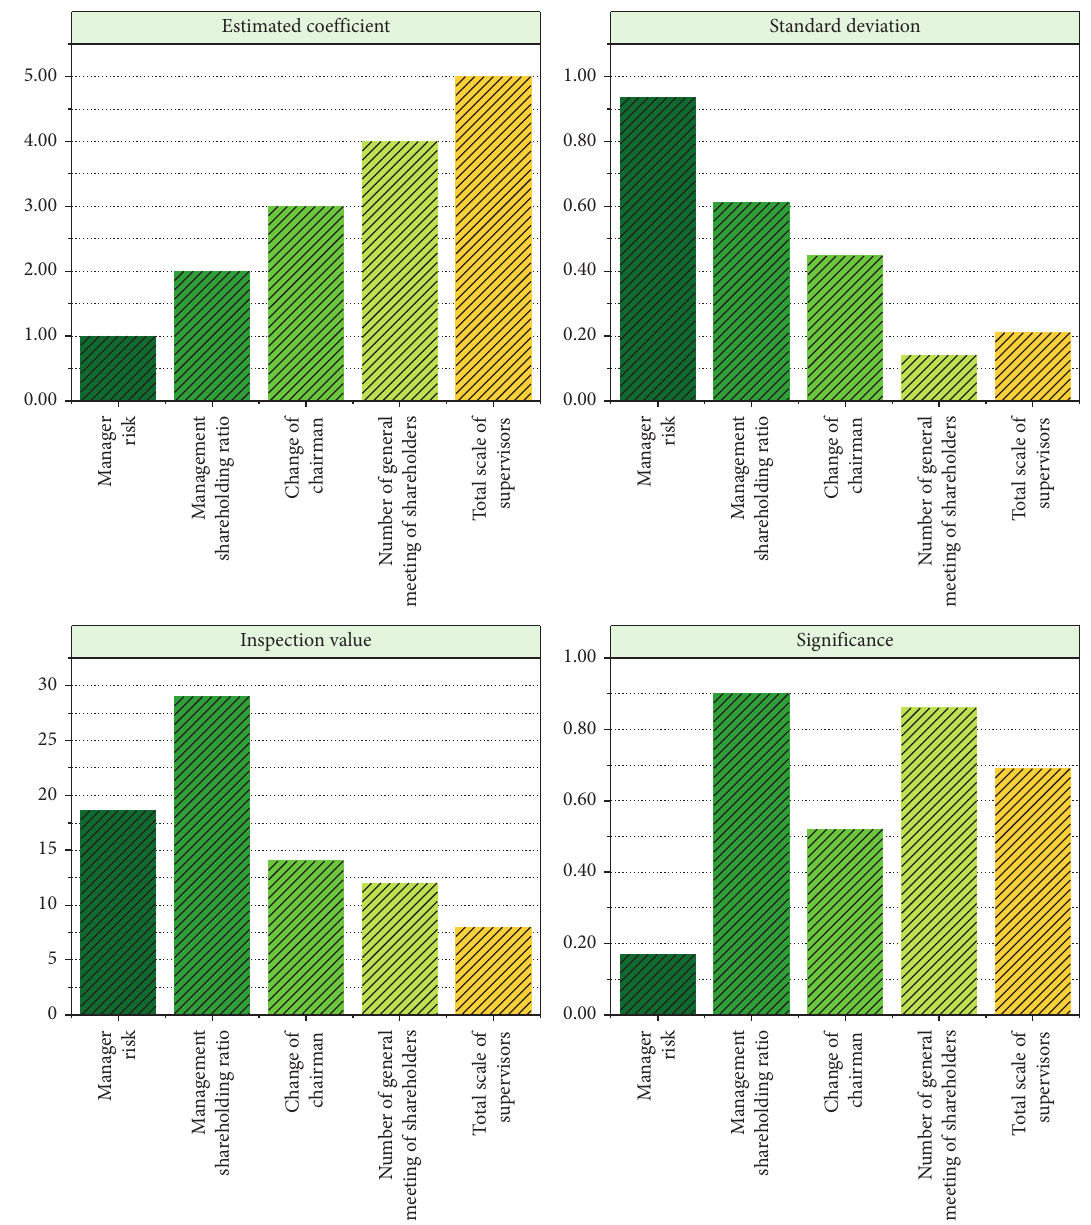
Figure 5: Analysis on the regression model of